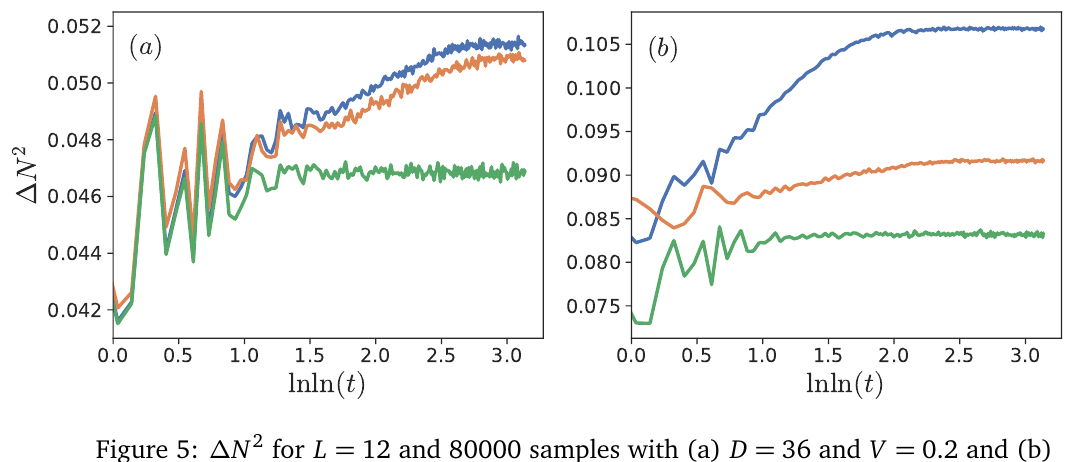
Figure 5: ∆ N 2 for L = 12 and 80000 samples with (a) D = 36 and V = 0.2 and (b) D = 20 and V = 2.0. The largest particle number fluctuations occur in the full model (blue) while the particle number fluctuations quickly saturate in the Anderson case (green). The effective model is in between those two cases